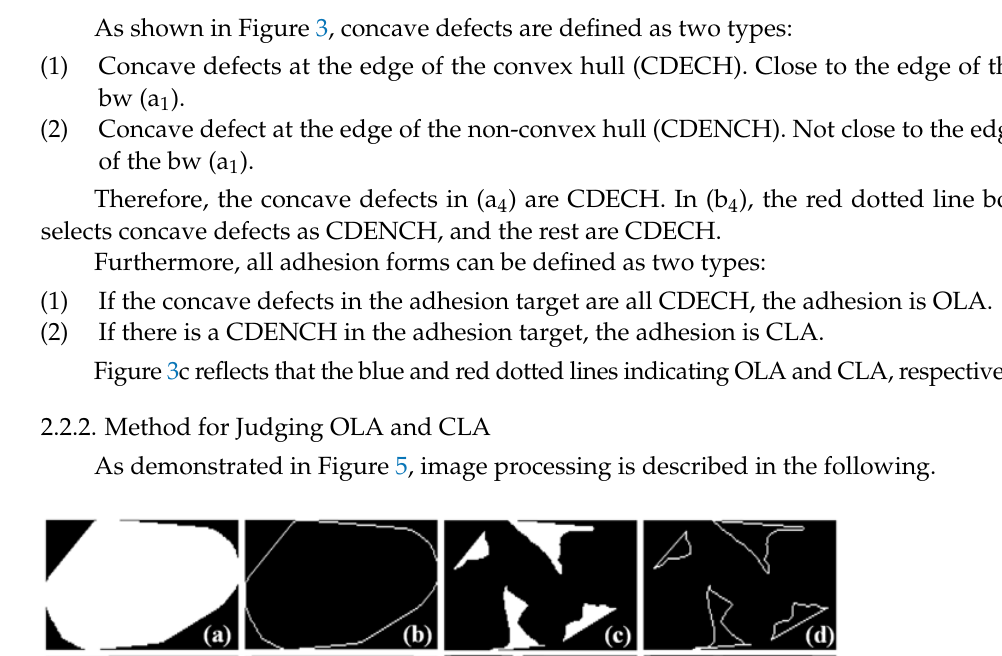
Figure 4. Area distribution of concave defect pixel.